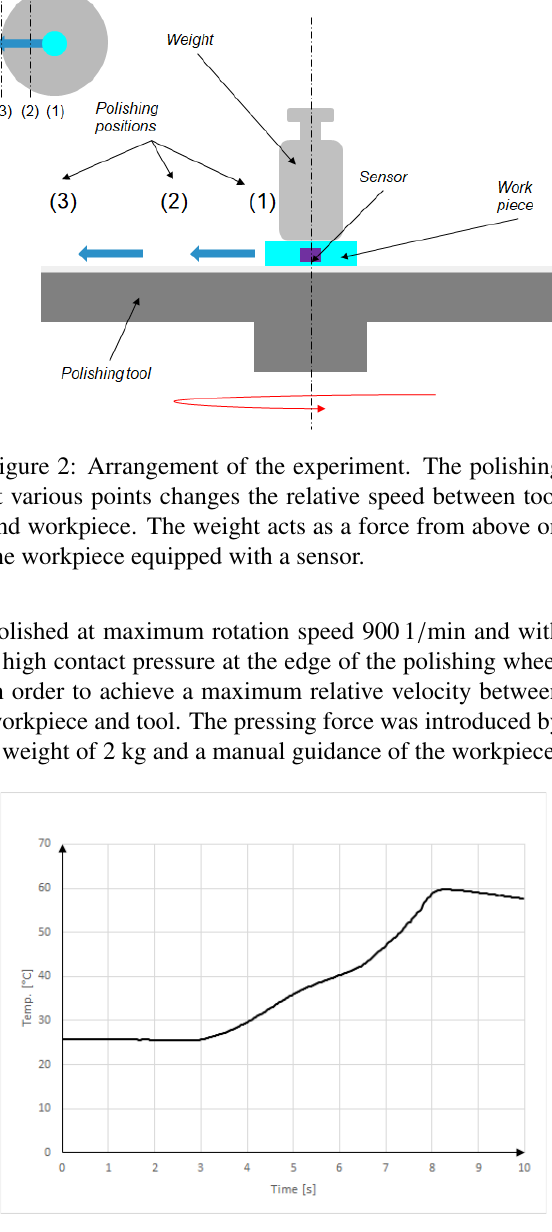
Figure 3: Temperature development of the glass lens shown in figure 1 with approximately constant high pres- sure and maximum adjustable speed of the polishing wheel. The highest reached value is almost 60 ◦ C. At this point, the experiment was stopped to prevent dam- age to the polishing wheel. Immediately after finishing the polishing process, a cooling of the workpiece can be